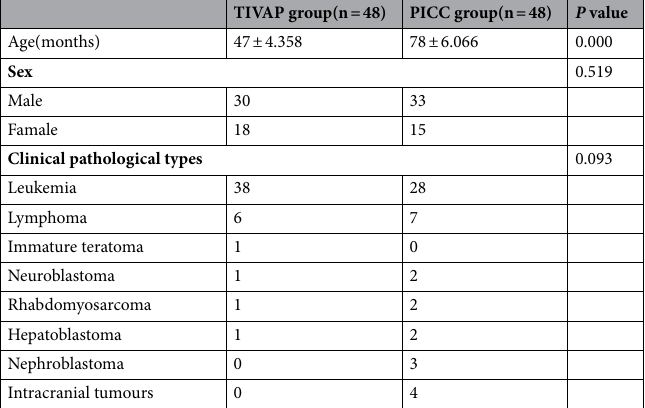
Table 1. General information [n (%)] (mean ± SD).